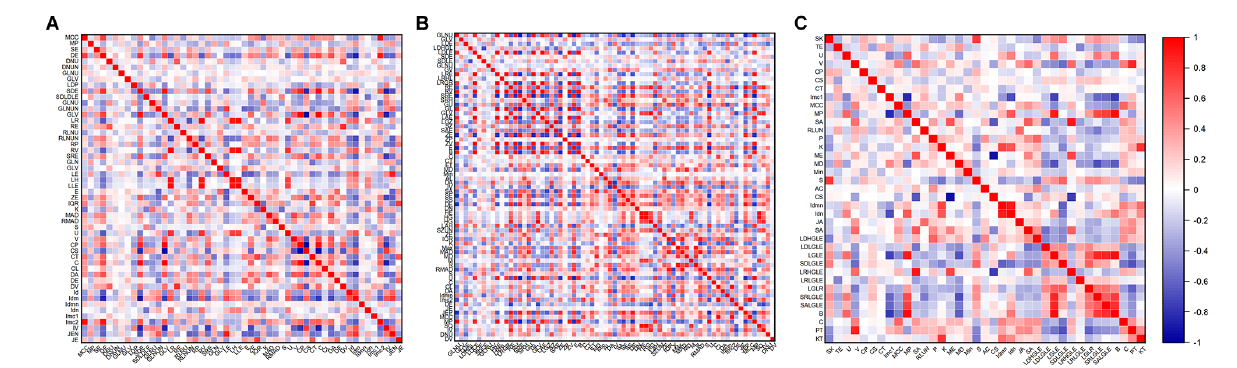
FIGURE 1 | Correlation analysis graph of the EOAD-YC groups (A) , the LOAD-OC groups (B) , and the EOAD-LOAD groups (C) . EOAD, early-onset Alzheimer’s disease; LOAD, late-onset Alzheimer’s disease; YC, young control; OC, old control.